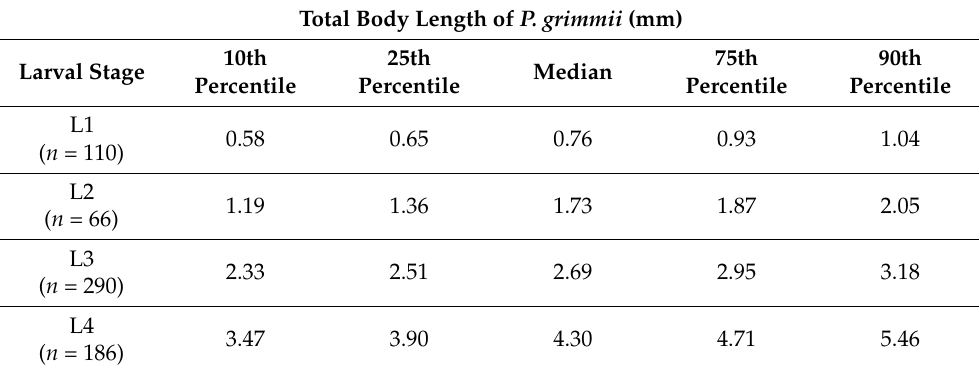
Table 3. The total body lengths of the Paratanytarsus grimmii larval